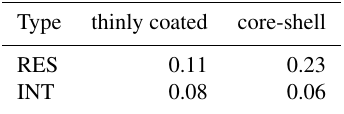
Table 2. The average value of the O / C ratio of OM-containing par- ticles with thinly coated and core-shell mixing structures.